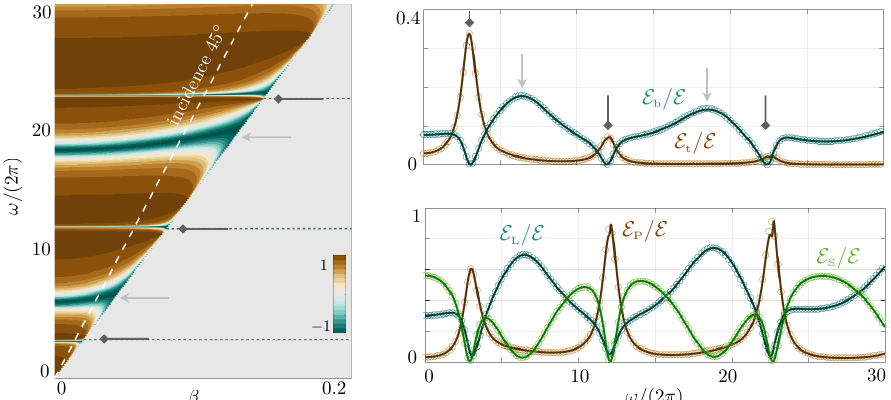
( 1,1 ) in colorscale against β and ∈ −